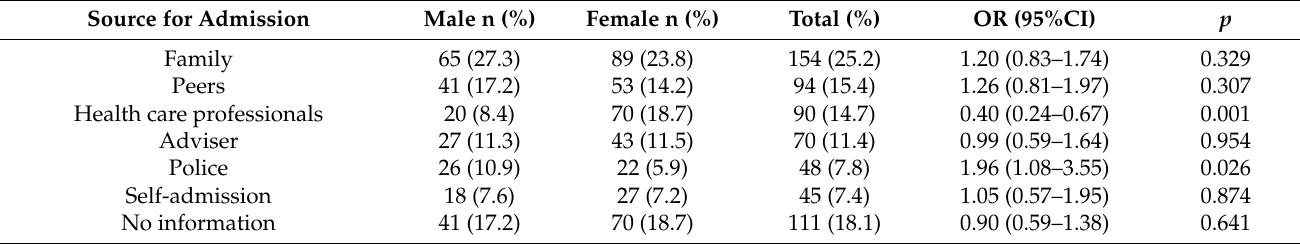
Table 4. Source for admission.